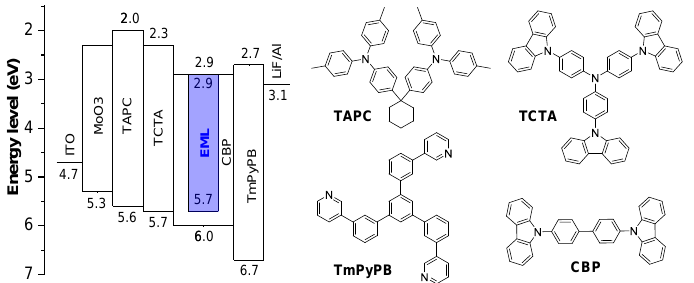
terms of color purity, the device based on TPIChCN with CIE coordinates of (0.15, 0.05) was in deeper blue emission color than TPIAnCN-based OLED. This suggests that the chrysene core is a deeper blue-emitting unit than the anthracene core. the chrysene core is a deeper blue-emitting unit than the anthracene core. the chrysene core is a deeper blue-emitting unit than the anthracene core.